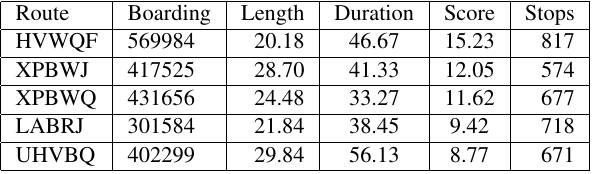
Table 3: First 5 Genetic algorithm generated routes